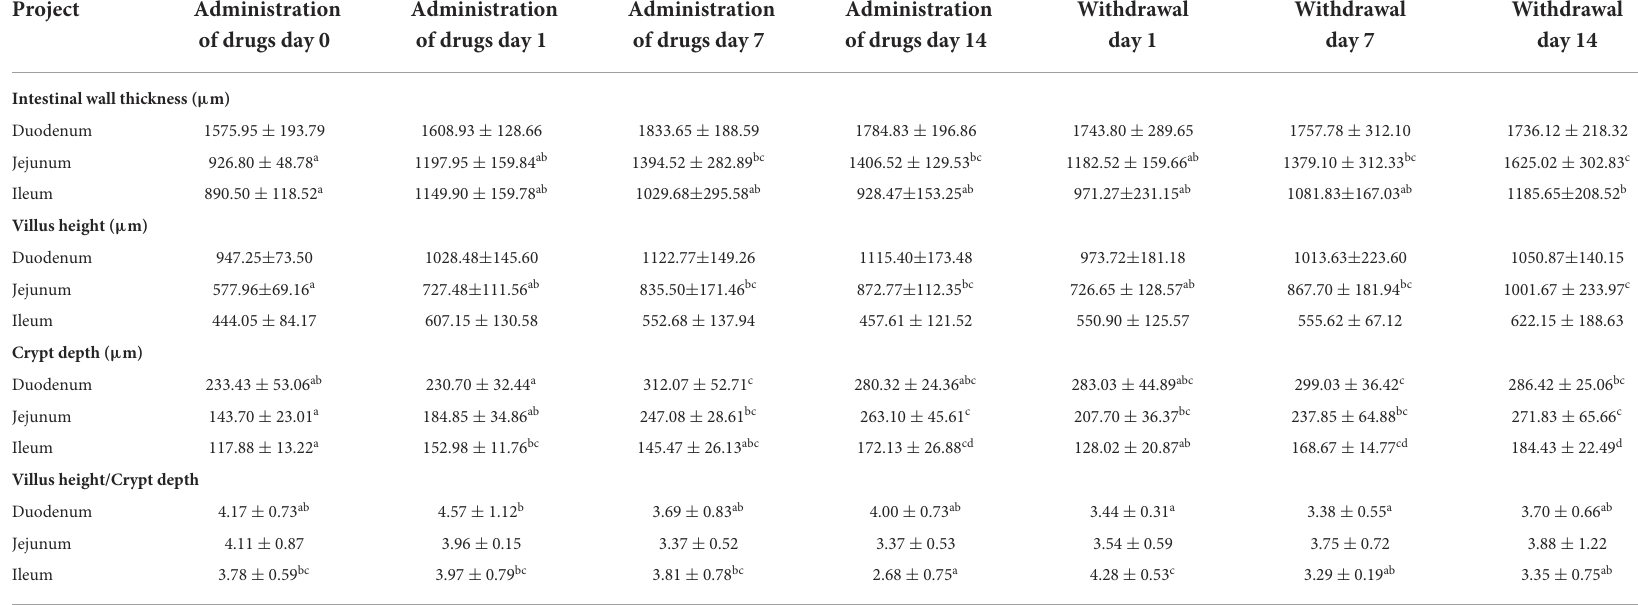
Superscriptlettersaftermeanvaluesindicatestatisticallysignificantdifferencesatp <